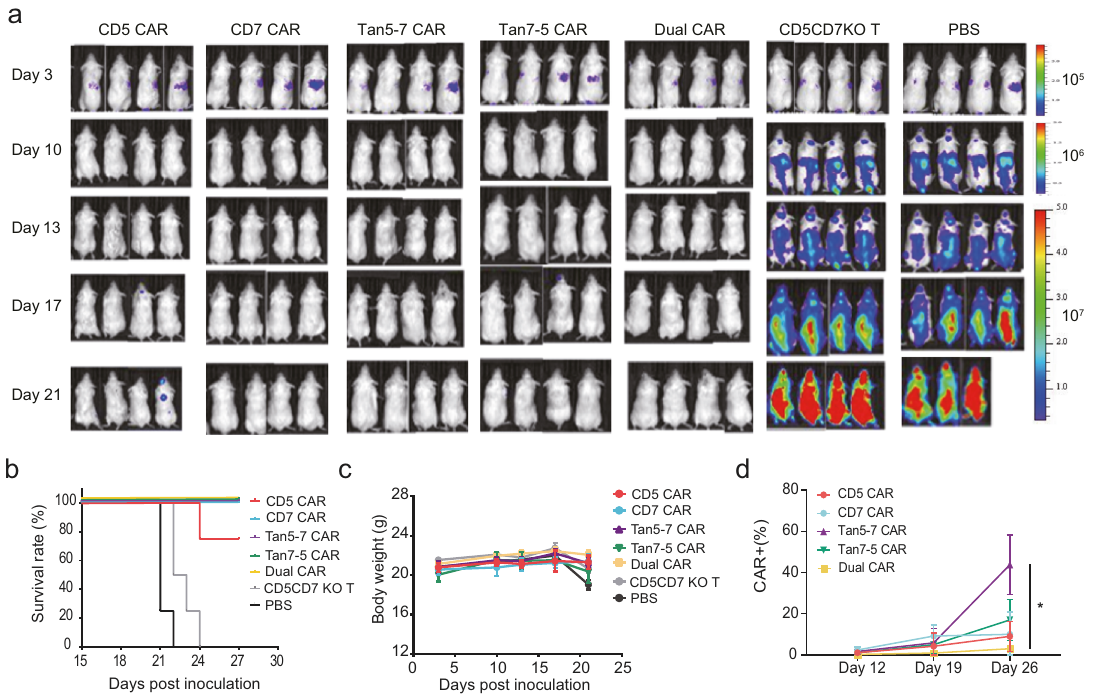
Fig. 5 The antitumor activity of CD5/CD7 bispeci fi c CAR-T cells in vivo. a Tumor growth and staging were monitored via bioluminescence imaging (BLI). b Overall Kaplan – Meier survival curve (log-rank test). Mice treated with CAR-T cells showed signi fi cantly increased survival ( P < 0.0001) compared with those of CD5CD7KO T and PBS-treated groups. c Body weight curve. The results are shown as mean ± SEM ( n = 4). d Relative frequency of CAR + T cells (CD45 + EGFRt + ) in peripheral blood of indicated CAR-T-treated mice groups on days 12, 19, and 26, respectively ( n = 4). * p < 0.05, two-way assess the effect of CAR-T treatment on heterogeneous leukemia cells. Compared with single CAR targeting T cells, CD5/CD7 bispeci fi c CAR-T cells conferred robust protection against the accumulation of single antigen-positive leukemia cells in the peripheral blood of mice (Fig. 6f and Supplementary Fig. 12), and the proportion of CD8 + CAR-T cells in the peripheral blood of mice in the CD5/CD7 bispeci fi c CAR-T treated groups were signi fi cantly higher than those in the CD5 CAR-T treated group on day 19 (Fig. 6g).